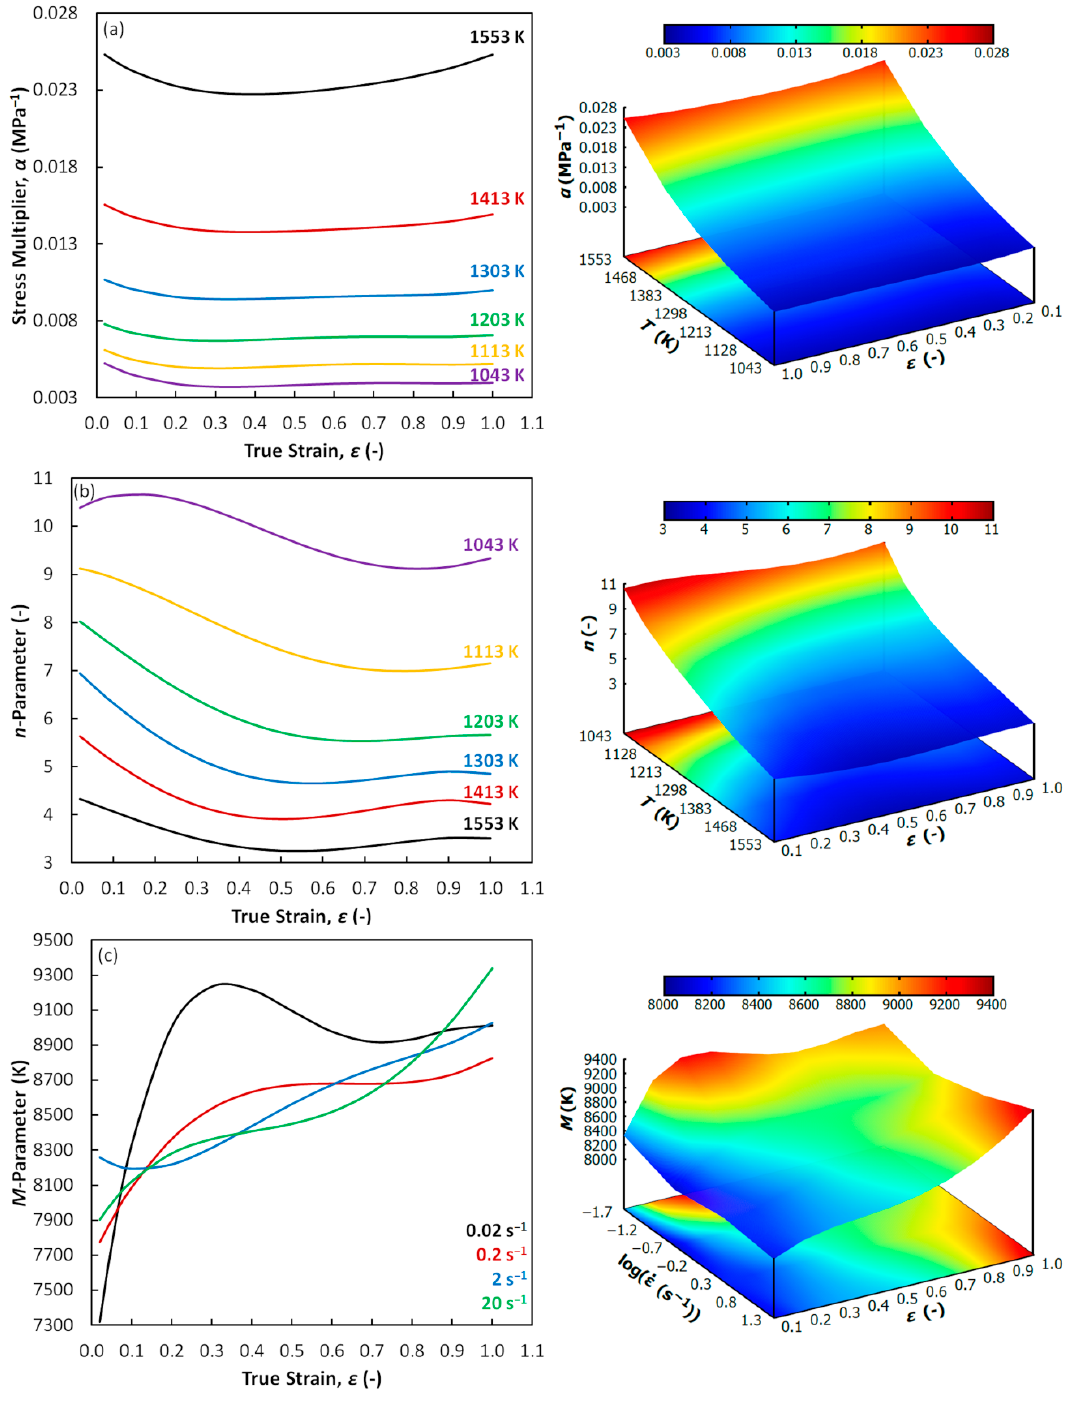
Figure 8. Evolution of the parameters for the activation energy calculation. ( a ) Stress multiplier α ; ( b ) parameter n ; ( c ) parameter M .